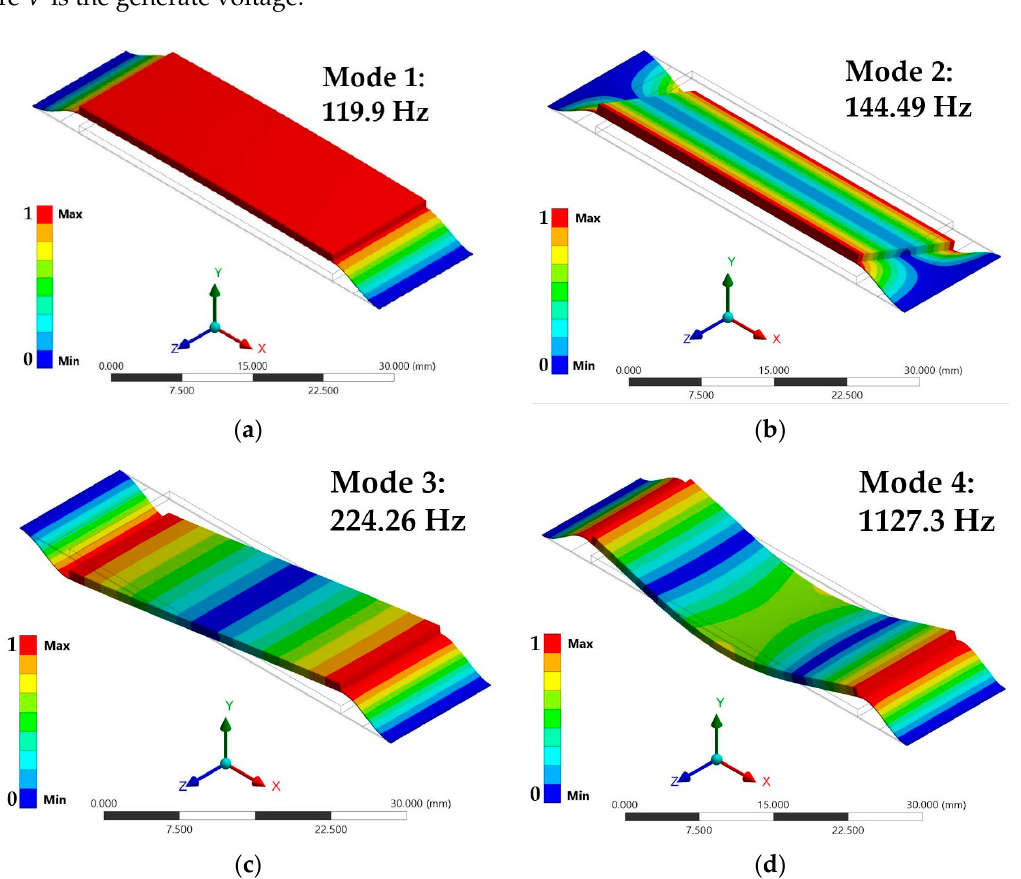
Figure 7. ( a ) First, ( b ) second, ( c ) third and ( d ) fourth vibration mode of the FEM models of the piezoelectric nanogenerator.